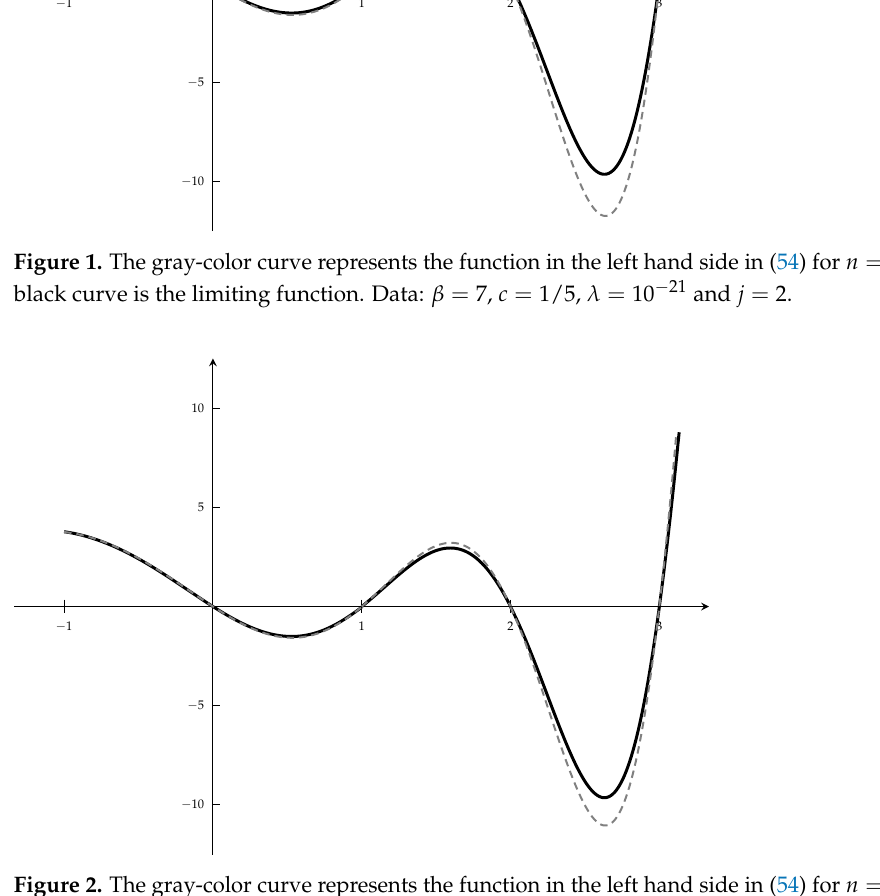
Figure 2. The gray-color curve represents the function in the left hand side in (54) for n = 70, and the black curve is the limiting function. Data: β = 7, c = 1/5, λ = 10 − 21 and j =